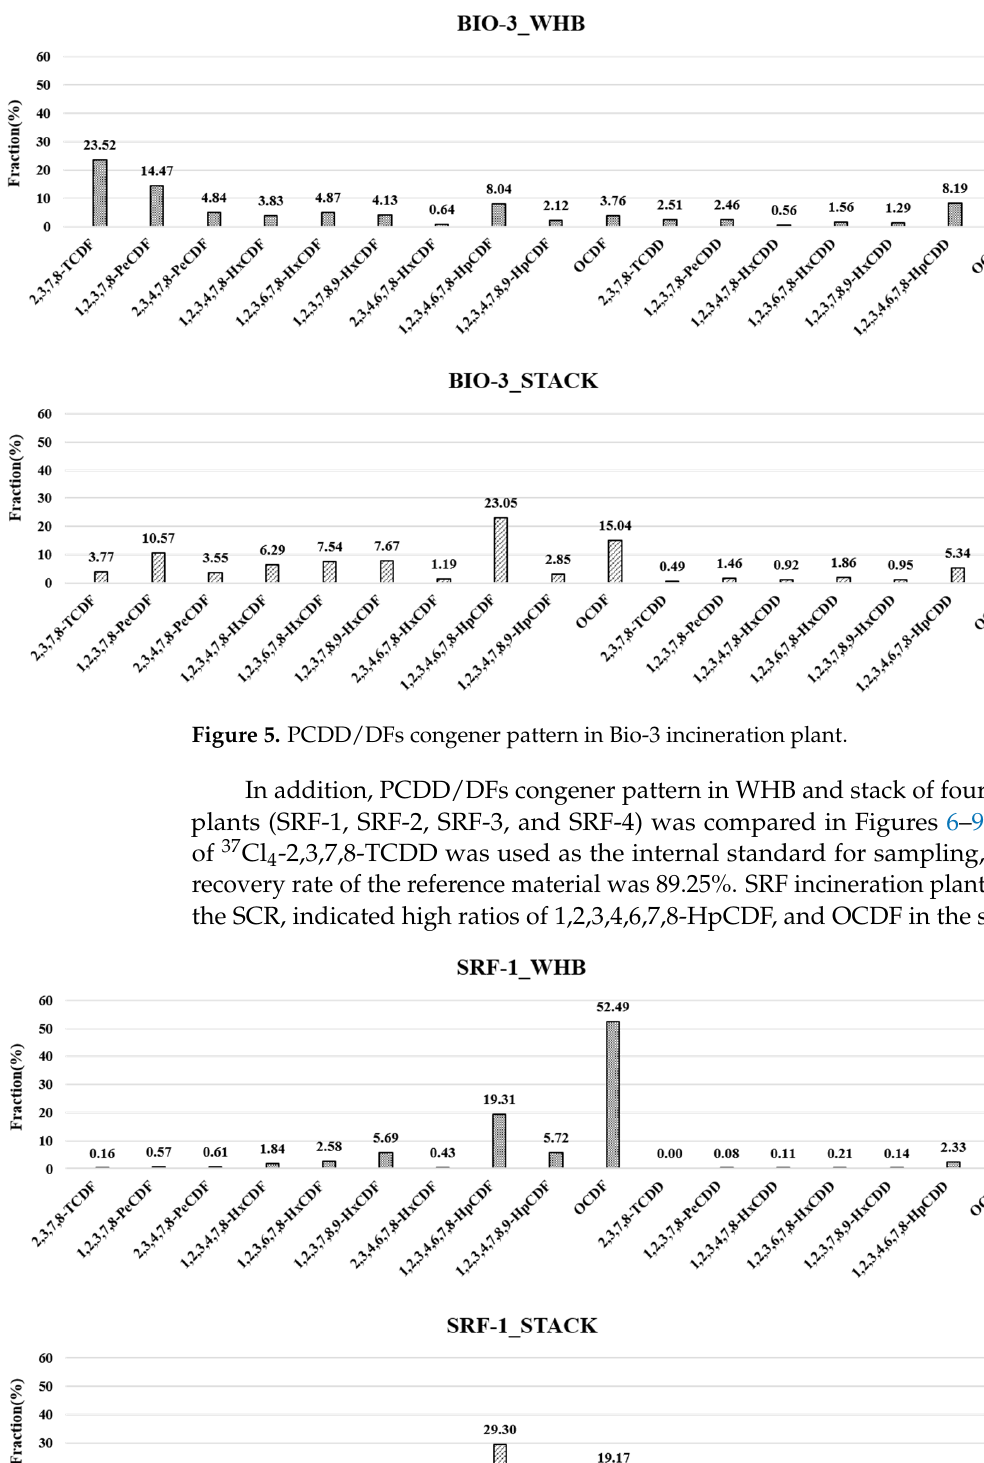
Figure 4. PCDD/DFs congener pattern in Bio-2 incineration plant.